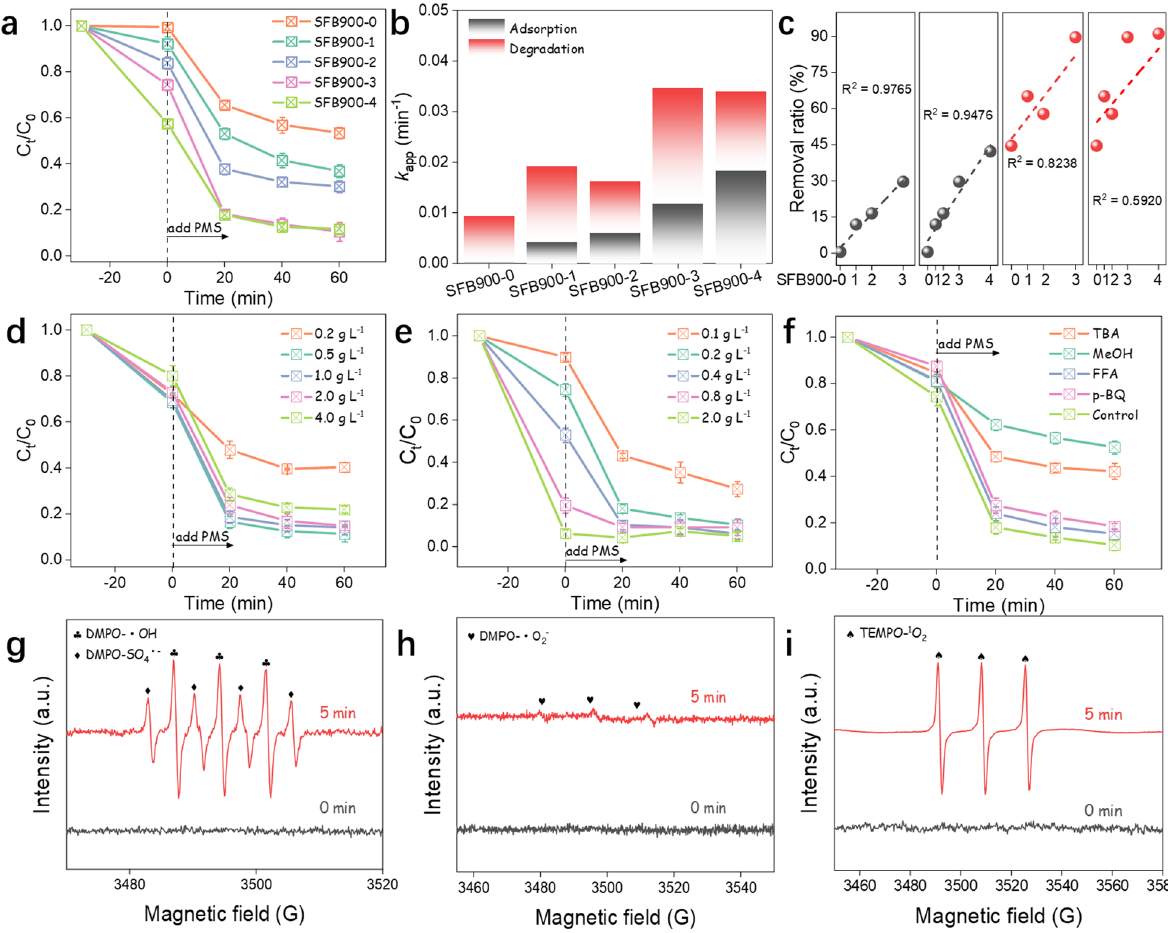
Fig. 3 a Adsorption and degradation performance of all as-prepared materials on NTP and ( b ) the related k app . c Correlation analysis of iron content and adsorption/ degradation capacity of all as-prepared materials. The effect of ( d ) PMS dosage and ( e ) catalyst dosage on NTP removal. f Quenching experiment on NTP removal by prepared materials. EPR detection of ( g ) hydroxyl radical, sulfate radical, ( h ) superoxide radical and ( i